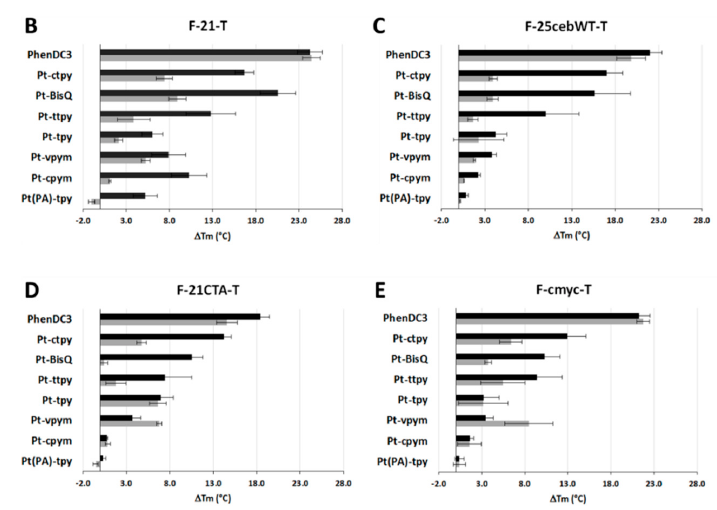
Figure 1. ( A ) A radar plot representing Δ T m values obtained from FRET-melting experiments in the presence of various terpyridine-Pt complexes: Pt-ctpy , Pt-BisQ , Pt-ttpy , Pt-tpy , Pt-vpym , Pt-cpym , and Pt(PA)-tpy and PhenDC3, used as a control. Δ Tm of ( B ) F-21-T, ( C ) F-CEB25-WT-T, ( D ) F-21CTA-T, and ( E ) F-c-myc-T in the presence of 0 (black bars) or 10 µM (grey bars) of duplex DNA(ds26) used as the competitor in a K + 1 buffer, except for F-21-T (K + 10 buffer). The values are given in Table S1.